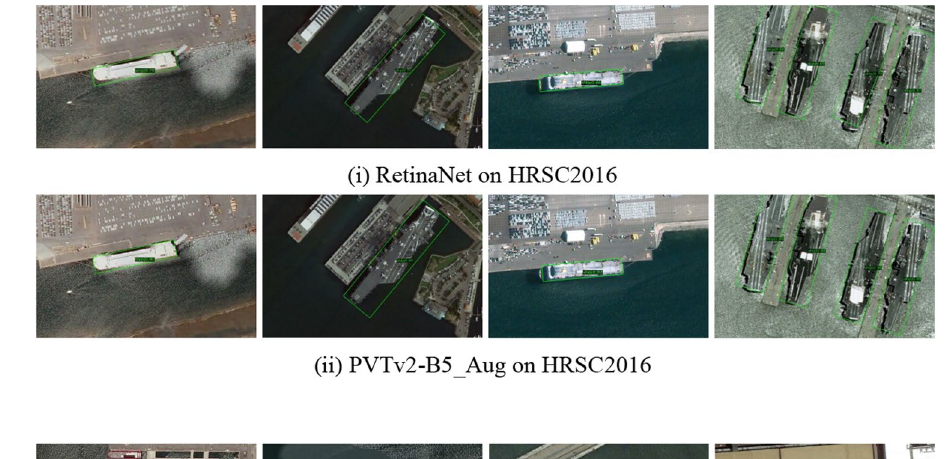
Fig. 10 Effectiveness of PVTv2-B5_Aug with fine- grained experiment on HRSC2016